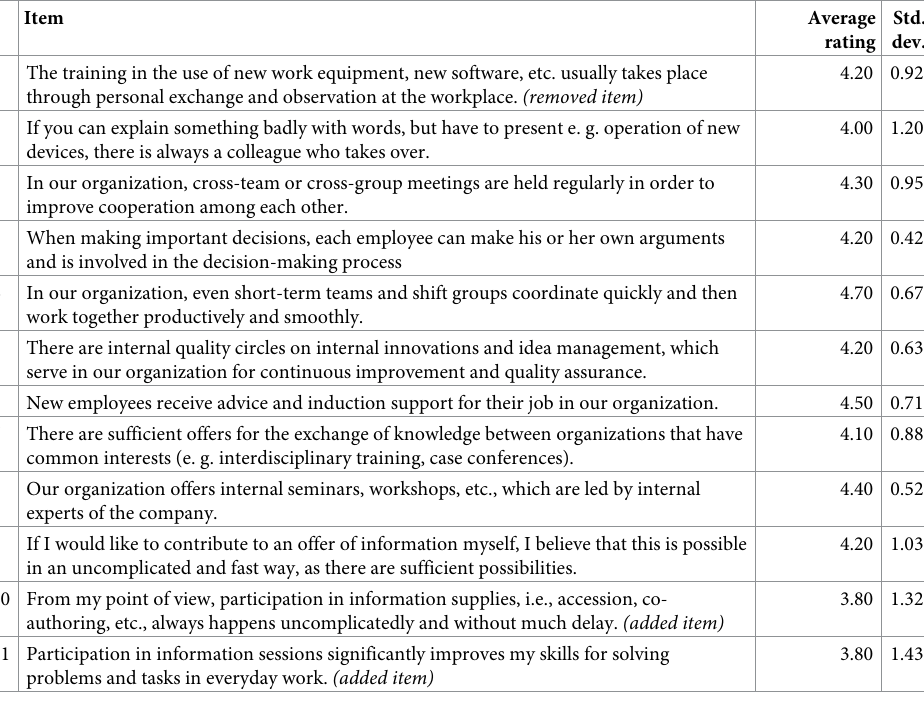
Table 3. Scale on active individual knowledge transfer based on expert ratings (with average rating and standard deviation).